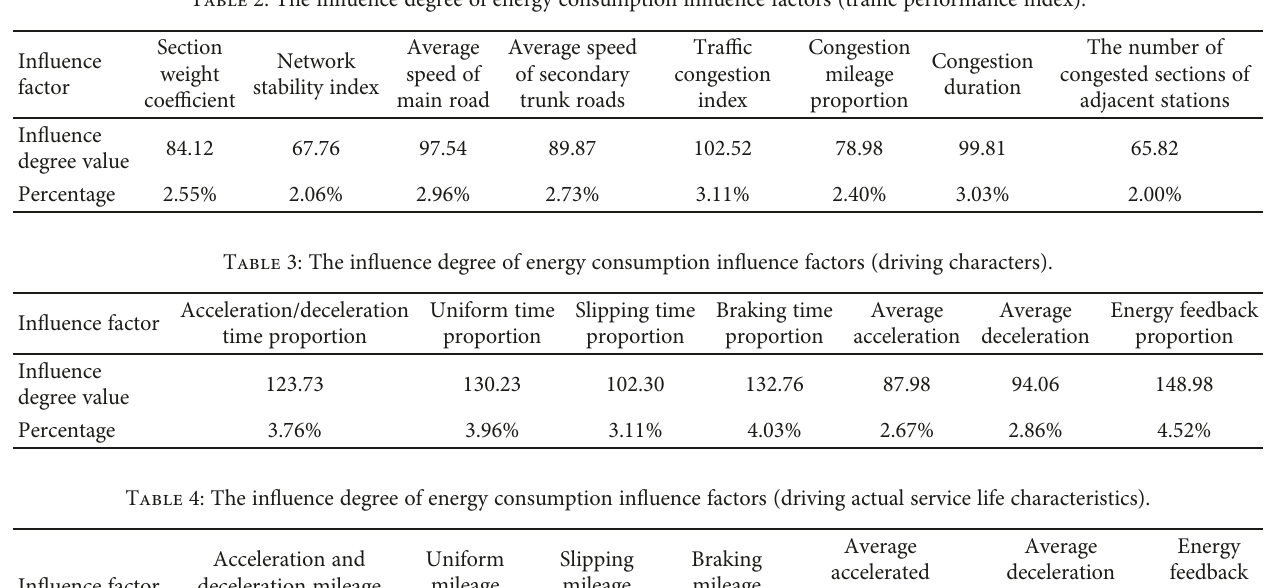
Table 2: The in fl uence degree of energy consumption in fl uence factors (tra ffi c performance index).